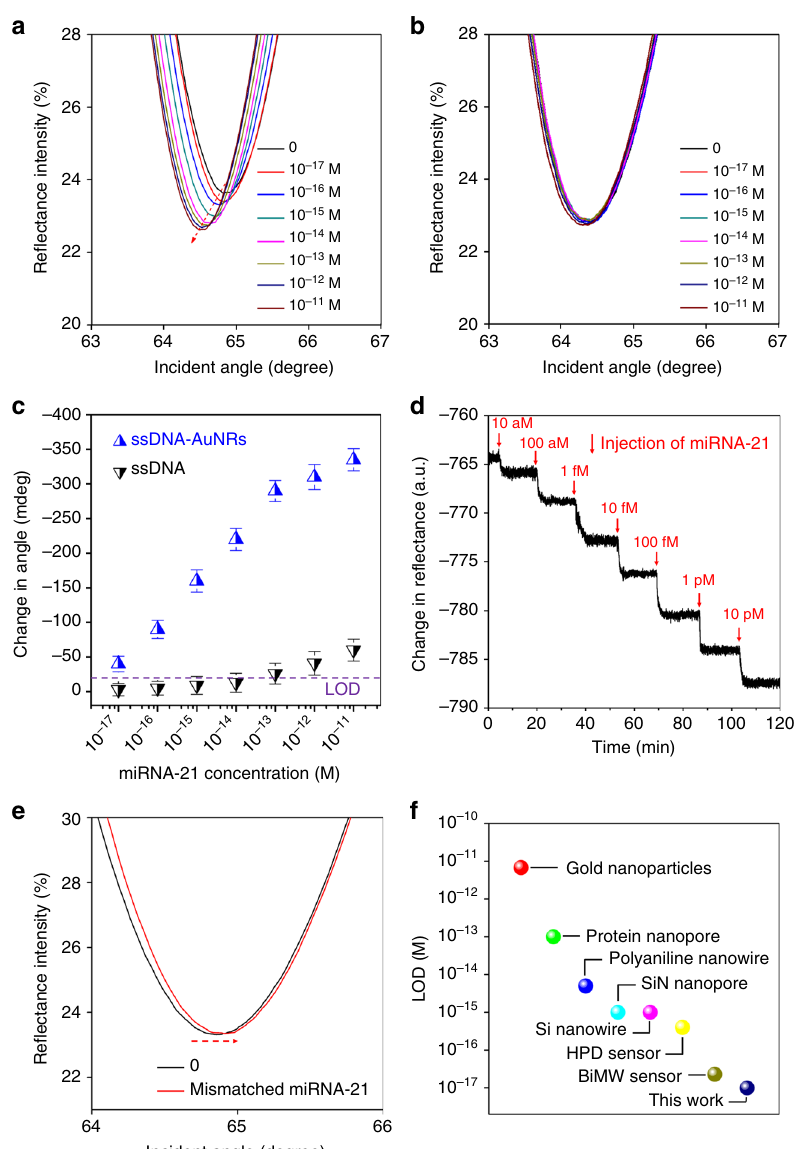
Fig. 5 Sensing miRNA-21 using an antimonene SPR sensor. a SPR spectra with miRNA-21 concentrations ranging from 10 − 17 to 10 − 11 M using AuNRs ampli fi cation. The arrow denotes the shift in the SPR angle. b SPR spectra with miRNA-21 concentrations ranging from 10 − 17 to 10 − 11 M without AuNRs. c The relationship between the SPR angle and miRNA concentration. Each point corresponds to the SPR angle shift with the indicated miRNA concentration. All error bars is the standard error of SPR angle shift from fi ve data points. d The real-time SPR response of ssDNA-AuNR desorption from the antimonene surface. e The SPR curve change of miRNA-21 contained one mismatched nucleobase (red line). f Comparison of the LOD of the antimonene miRNA SPR sensor with that of state-of-the-art sensors (Sb) powder at an initial concentration of 30mg mL − 1 was dispersed in a glass vial We used the vdW-optB86b functional to properly take into account the long-range van der Waals interactions 56 . containing ethanol. Subsequently, the Sb powder solution was sonicated for 1h in FDTD simulation . The near- fi eld distribution of AuNRs on gold fi lm under a 632.8 nm incident laser was simulated by the FDTD method. To model the AuNRs on a gold fi lm, the FDTD method was used with antisymmetric and symmetric boundary conditions at the x – y axis and z – y axis, respectively. The propagation of the plane waves was directed along 45° from the x axis. For all simulations, the parameters of the AuNRs nanostructures were set according to the average sizes (70 nm) measured from the experimental results. The mesh size was 1nm. The electromagnetic fi eld distribution of the Au nanorod was calculated at incident light wavelengths of 632.8 nm. The refractive index of Au used for the simulation was taken from the source program. Synthesis of antimonene nanosheets . The antimonene nanosheets were pre- pared by probe-sonication liquid-phase exfoliation in ethanol. Pulverized antimony NATURE COMMUNICATIONS| (2019) 10:28